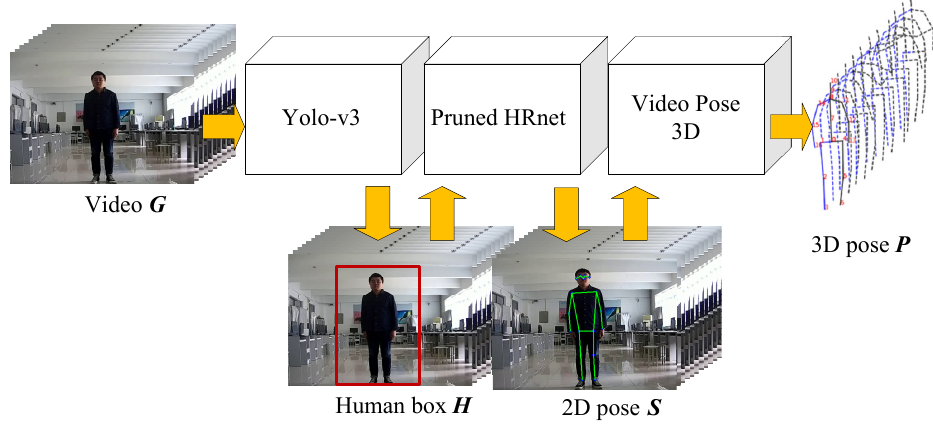
Figure 2. 3D human pose